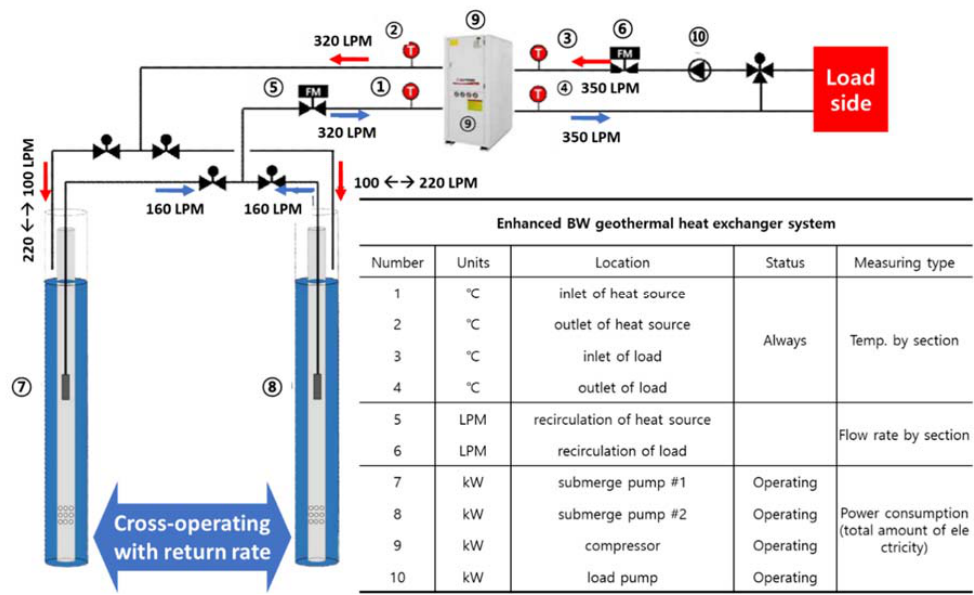
Figure 1. Schematic of the water-water geothermal heat pump system for operating standing column well (SCW) and balancing well geothermal heat exchanger system. LPM: liter per minute